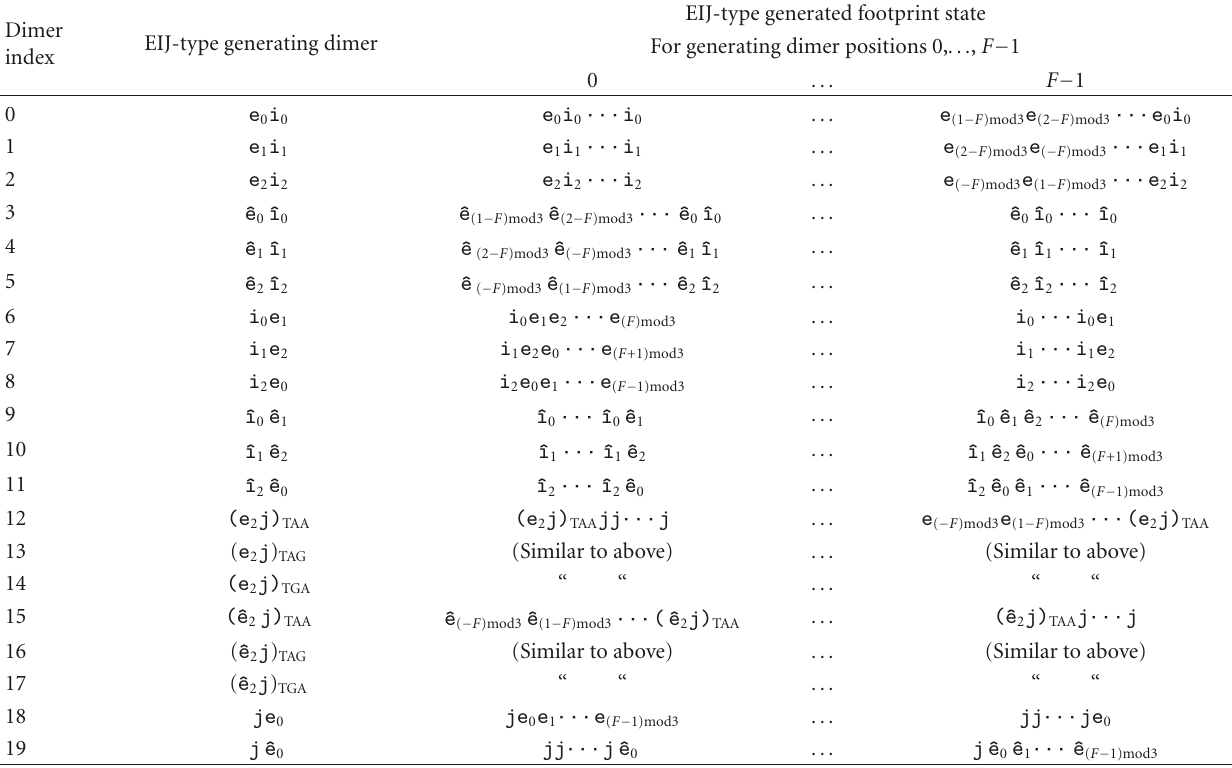
Table 6: All 20( F ) eij-type footprint states generated by the eij-type dimmers.